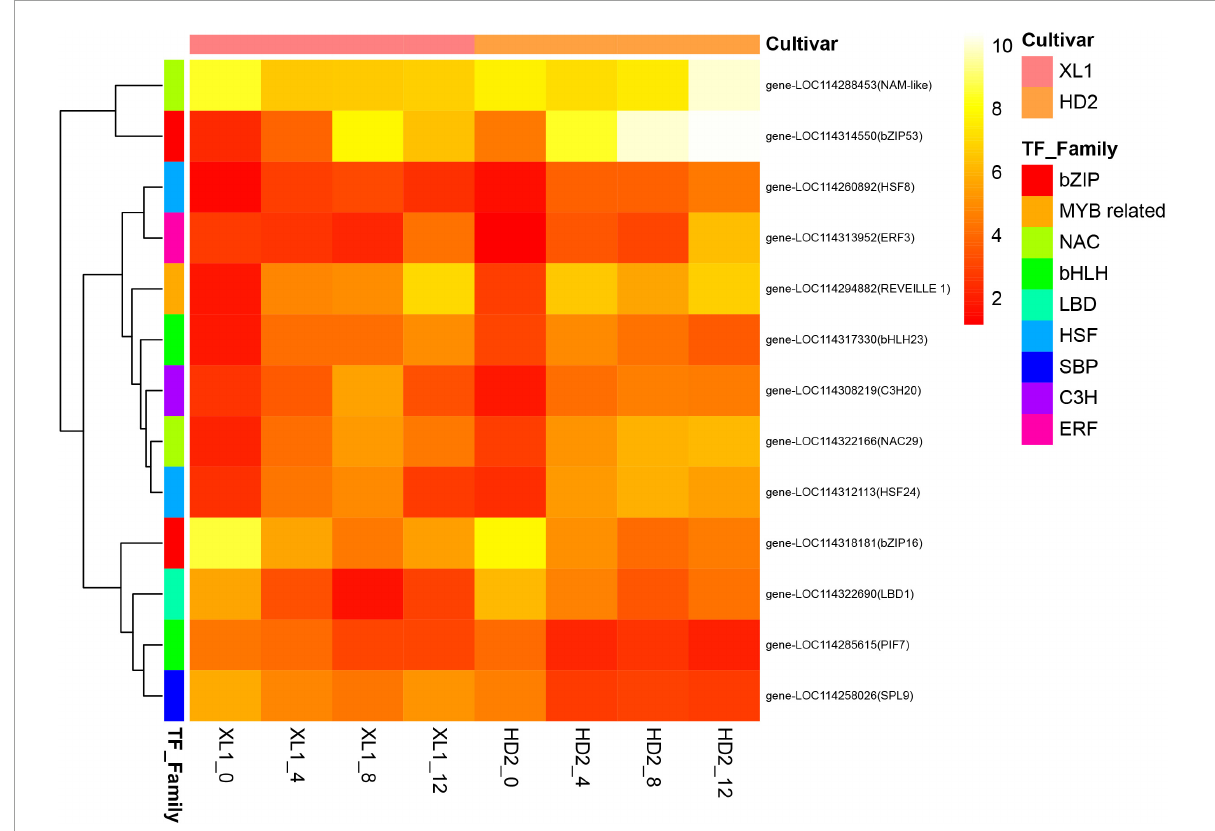
FIGURE8 The heatmap of differentially expressed transcription factors (TFs) during the drought stress treatment. The heatmap was generated from the log2 (FPKM + 1) of three replicates for each sample, and the values of clustering distance were “correlation” and the clustering algorithms was “complete.”